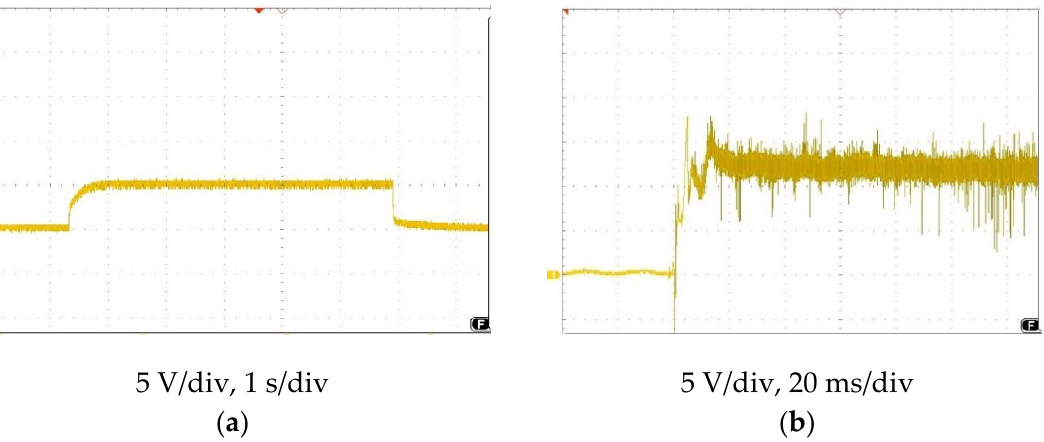
Figure 9. System response, ( a ) Step change in the reference voltage from V d = 5 V to V d = 10 V; ( b ) Inductor current 𝑖 (cid:3013)(cid:2869) waveform.